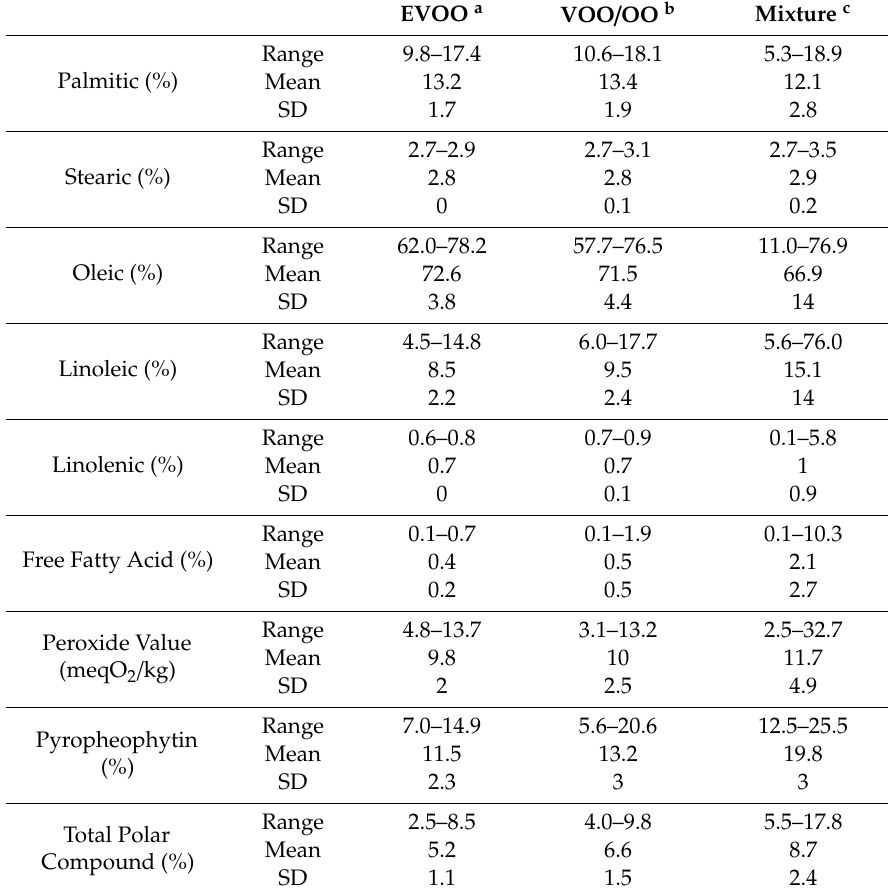
Table 1. Reference concentration levels for the compounds measured in olive oil